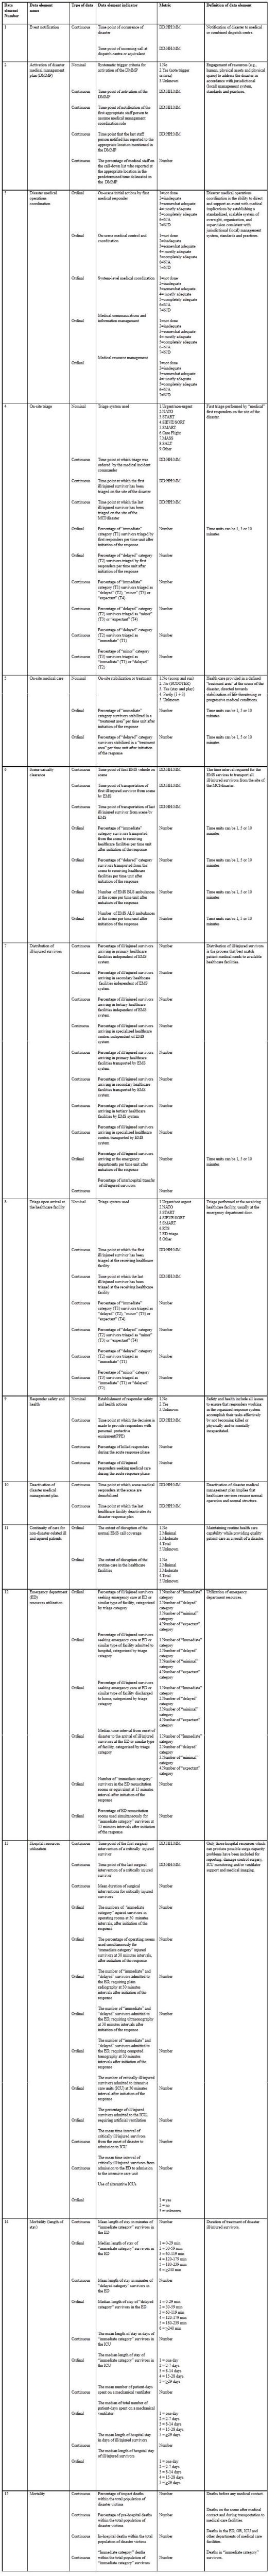
Table 1. Disaster Acute Medical Response data elements and indicators